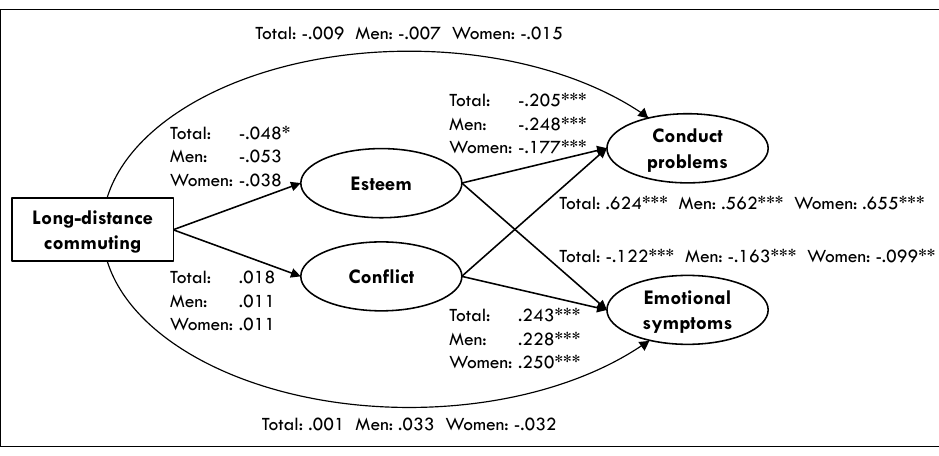
Figure 2 : The association between parents’ long-distance commuting, parent-child relationship and child well-being (evaluated by the parent)